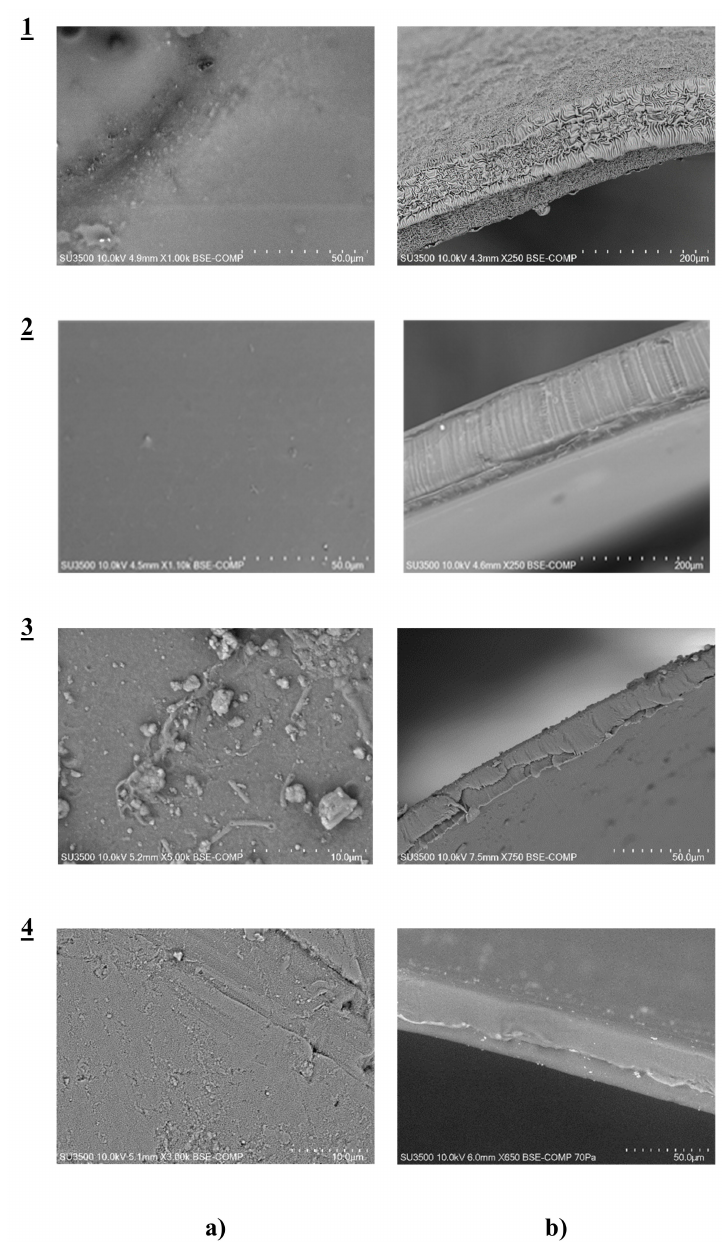
Figure 2. SEM images of polymer inclusion membranes (PIMs) containing 1-octylimidazole ( 1 ), 1-octyl-2-methylimidazole ( 2 ), 1-octyl-4-methylimidazole ( 3 ), and 1-octyl-2,4-dimethylimidazole ( 4 ) as a carrier: front view ( a ), cross-section along the diameter ( b